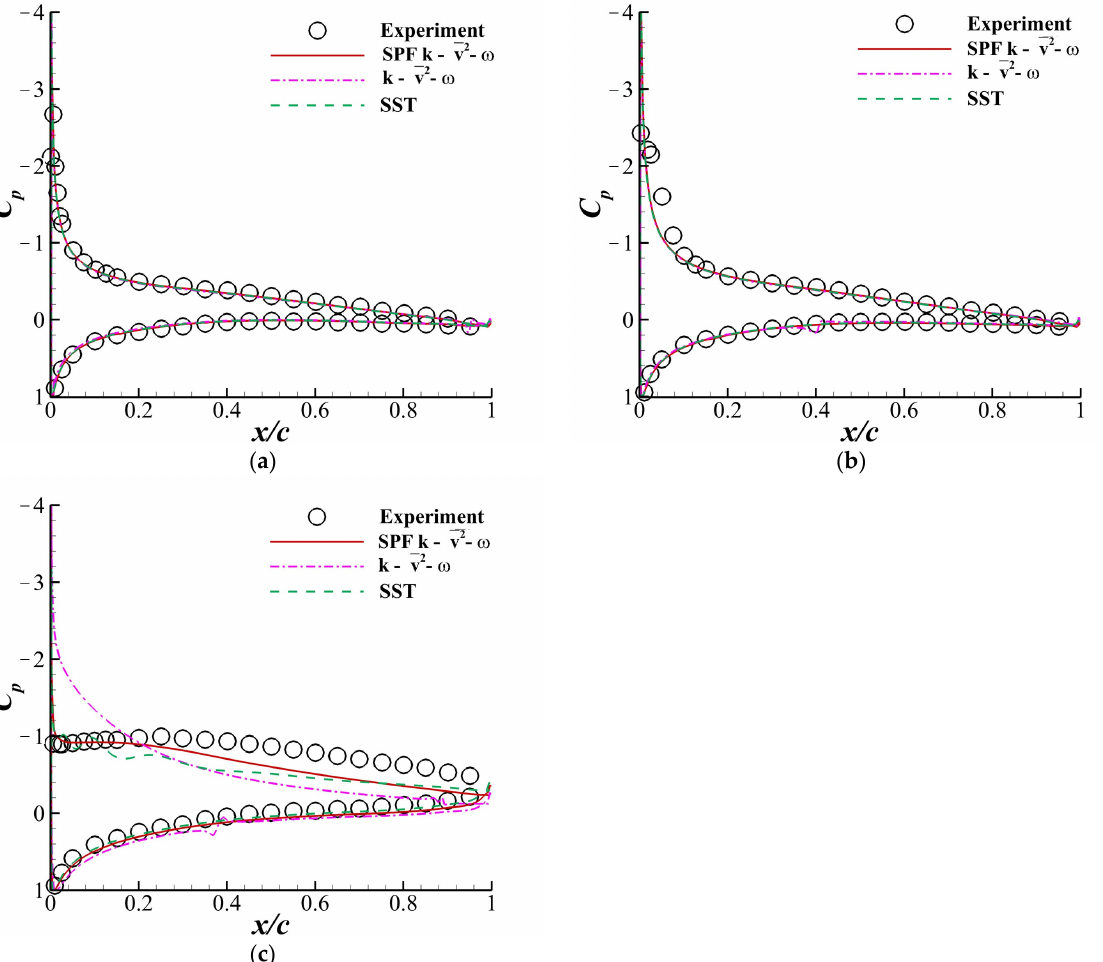
Figure 13. Pressure coefficient distributions on the NACA64A006 airfoil when Re = 5.8 × 10 6 M and a = 0.167. The symbols represent experimental data obtained by McCullough et al. [35]. ( a ) AOA = 4 ◦ . ( b ) AOA = 5 ◦ . ( c ) AOA = 10 ◦